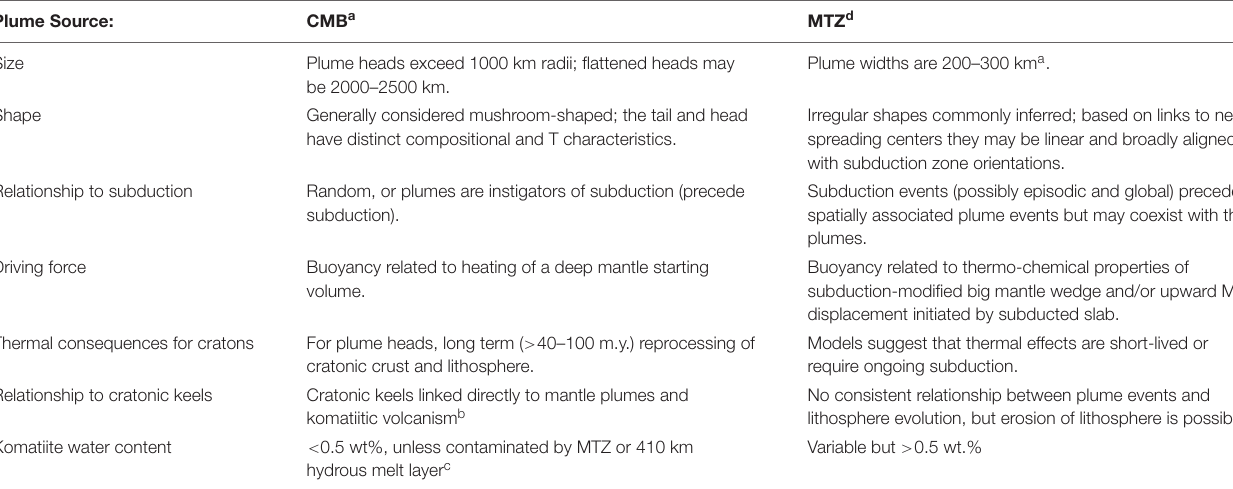
TABLE 1 | Distinguishing features of core-mantle boundary and mantle transition zone plume models. Plume